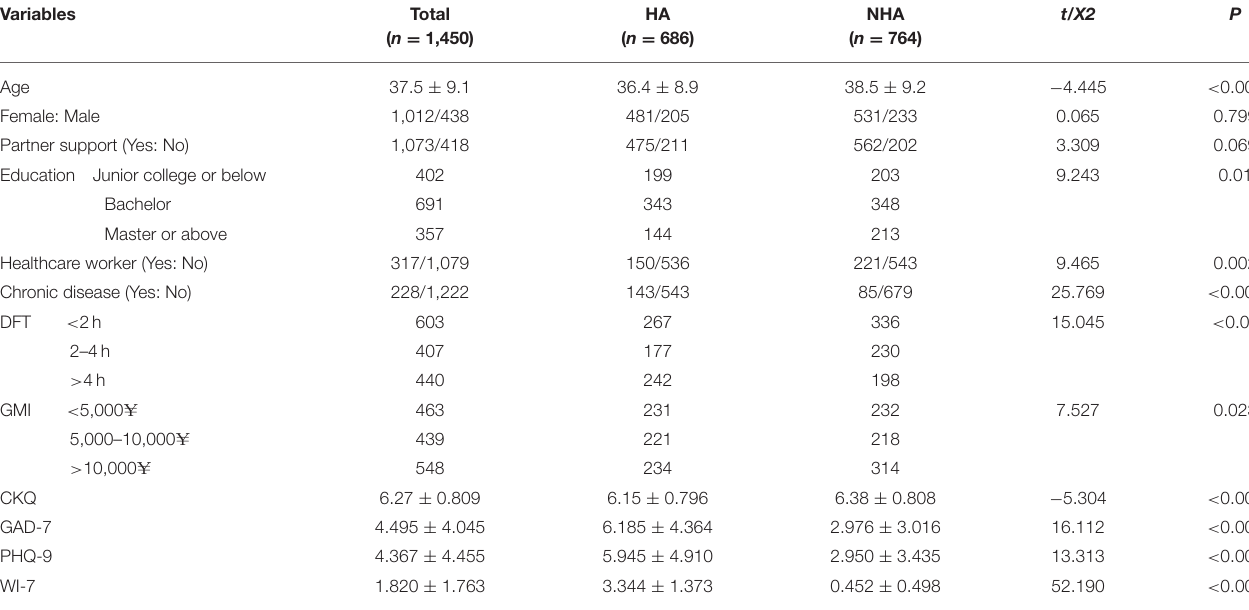
TABLE 1 | Group difference between HA and NHA in demographic and clinic